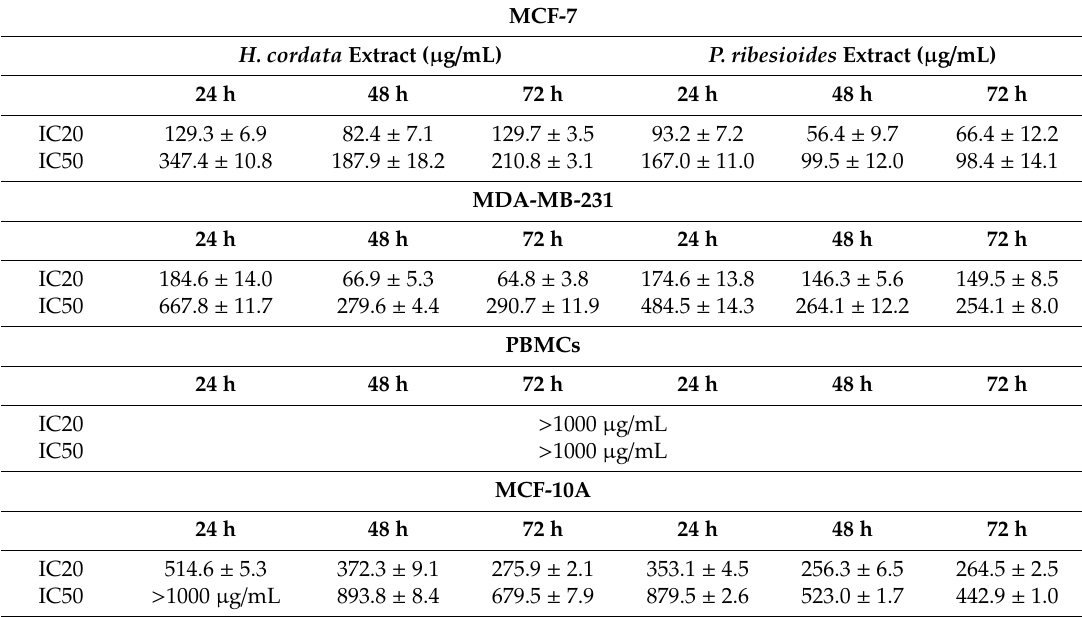
Table 5. Determination of IC20 and IC50 values of H. cordata and P. ribesioides extracts of breast cancer cells, peripheral blood mononuclear cells (PBMCs) and MCF-10A cell line. All cells were treated with various concentrations (100–500 µ g / mL) of H. cordata and P. ribesioides extracts for 24, 48 and 72 h. Results are presented as mean ± SD for three independent